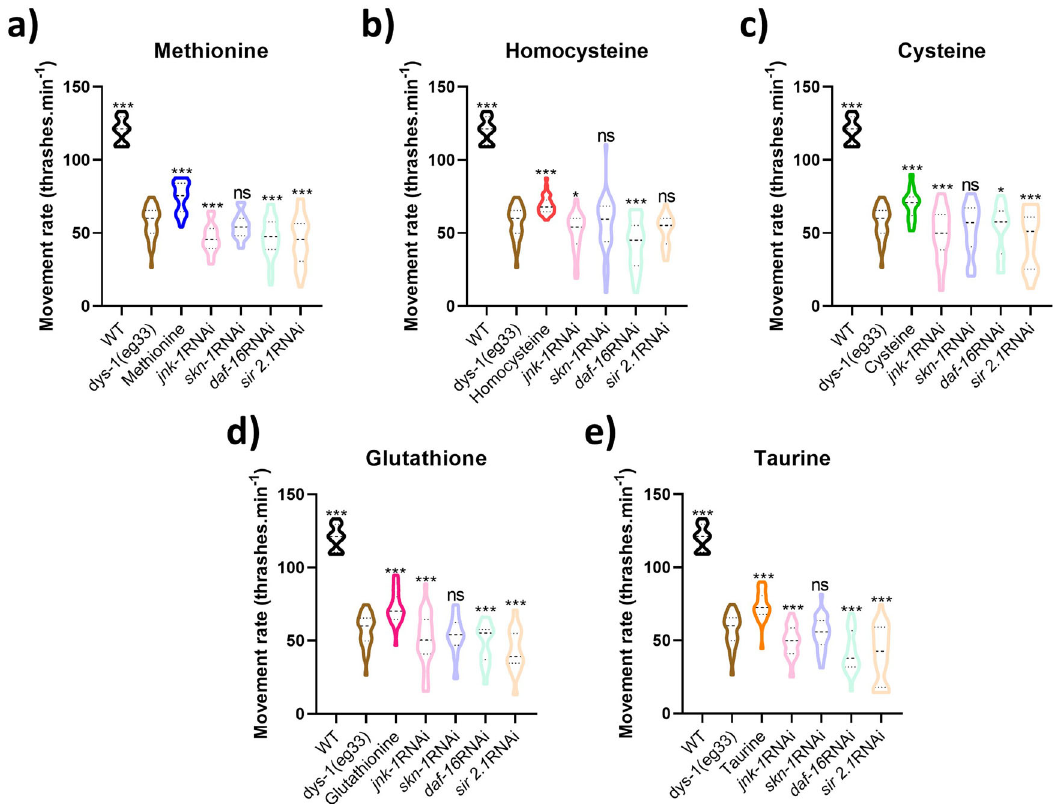
Fig. 8 Conserved cytoprotective genes are required for the health promoting effects of SAA. a L-methionine, b L-homocysteine, c L-cysteine, d L-glutathione and e L-taurine all require jnk-1, skn-1, daf-16 and sir-2.1 for their established health promoting effects on dys-1(eg33) movement capacity. Despite skn-1 co-treatments not presenting a signi fi cant decline in movement compared to untreated dys-1(eg33) , the lack of movement preservation (as seen with the compounds alone) suggests each SAA requires full expression of this gene. All strains and conditions represent data from 10 animals with averages taken from 5 separate counts and repeated across three biological repeats. Results were analysed with a two-way ANOVA. Asterisks denote signi fi cance to untreated dys-1(eg33) animals. *** P < 0.0001, * P < 0.05, ns P >